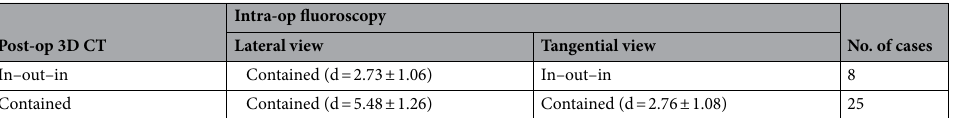
Intra-op fluoroscopy